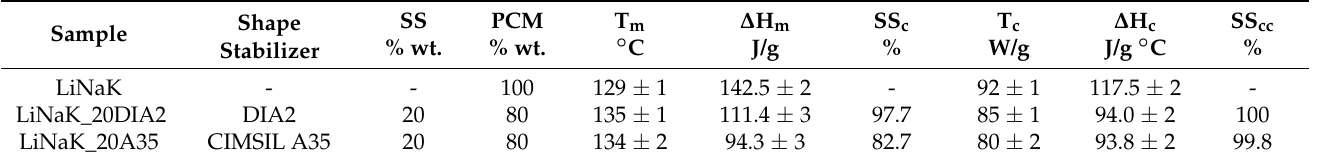
Table 4. DSC results at the 2nd heating/cooling cycle of the SSPCM (LiNaK-based) characterization.